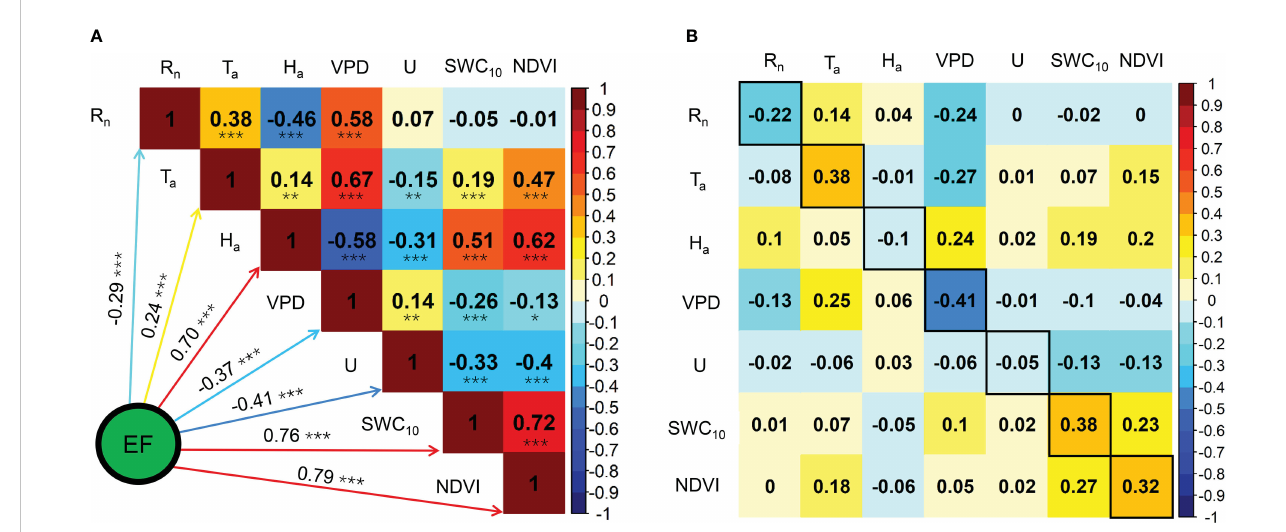
FIGURE 7 Correlation analysis (A) and path analysis (B) among midday EF and biophysical factors during the growing seasons in 2020 and 2021. * Signi fi cant at p< 0.05; ** signi fi cant at p< 0.01; *** signi fi cant at p<